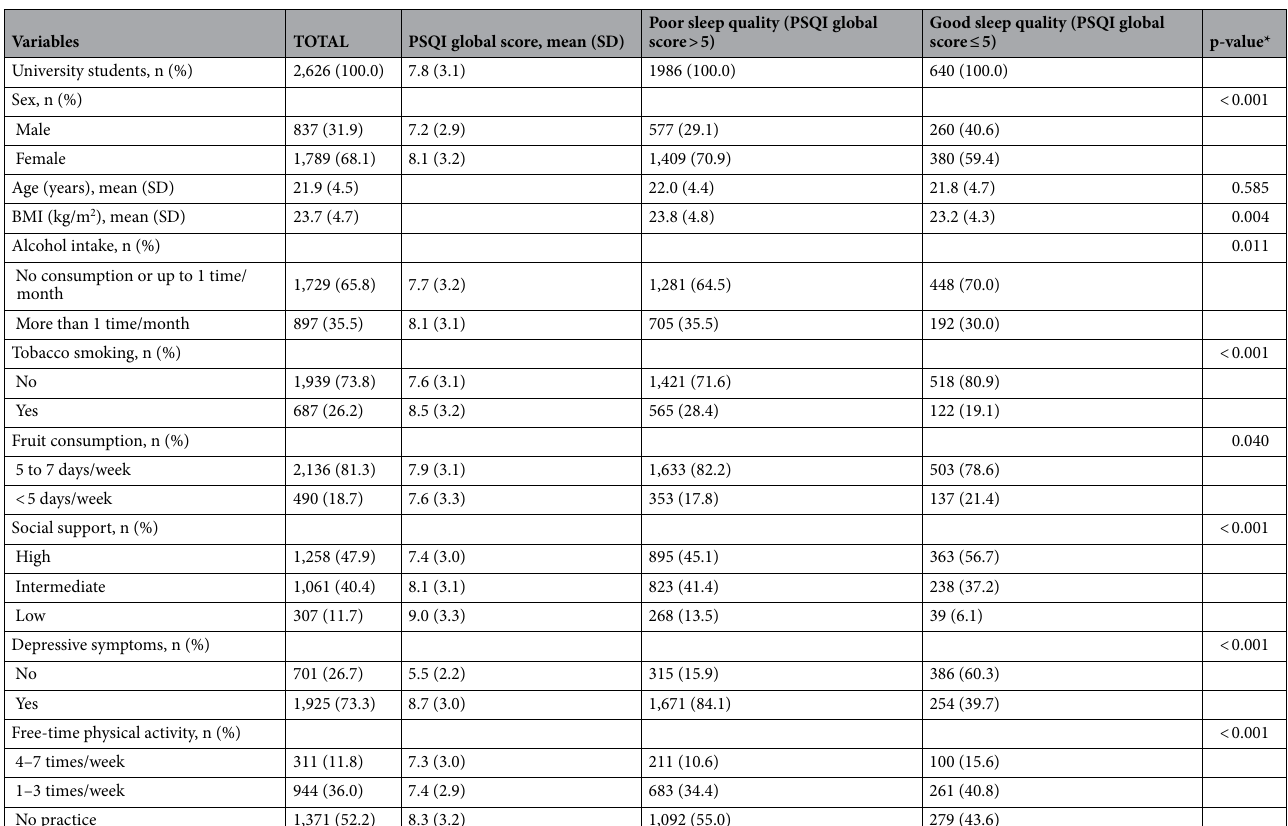
Table 1. Sociodemographic, lifestyle and health characterization of Brazilian university students according to sleep quality. PSQI Pittsburgh Sleep Quality Index, SD standard deviation, BMI body mass